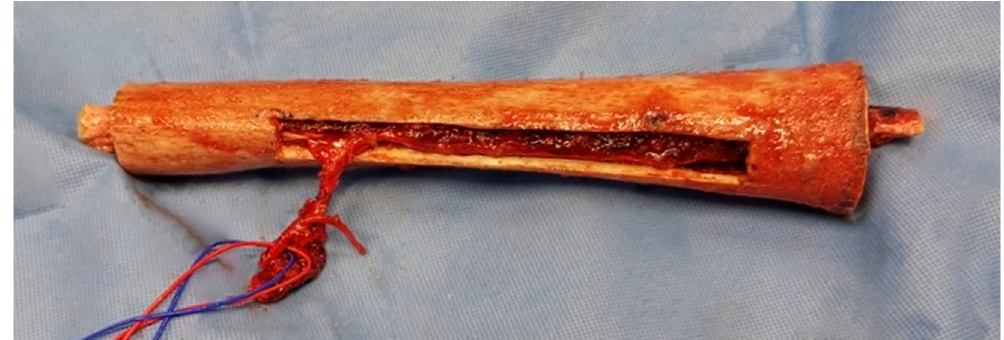
Figure 2. Vascularized fibula embedded in the femoral allograft before implantation. The allograft window makes vascular anastomosis possible. There was an extra 20 mm after each extremity of the fibula (patient No. 3).